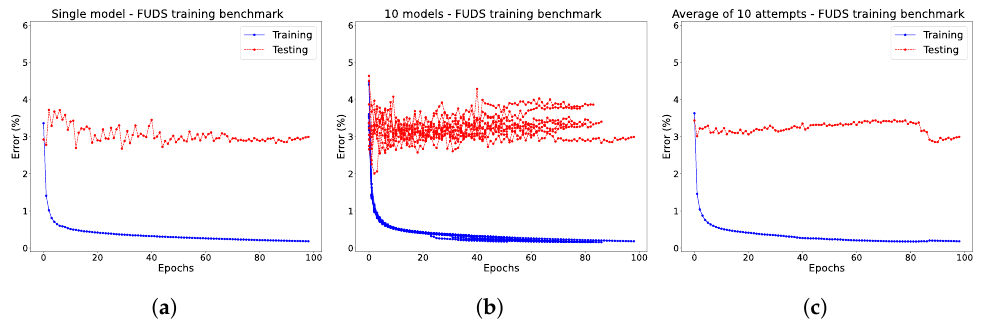
Figure 12. History results averaging demonstration. ( a ) Single model history for training and testing; ( b ) All 10 attempts of histories for training and testing; ( c ) Average of 10 attempts of histories for training and testing.